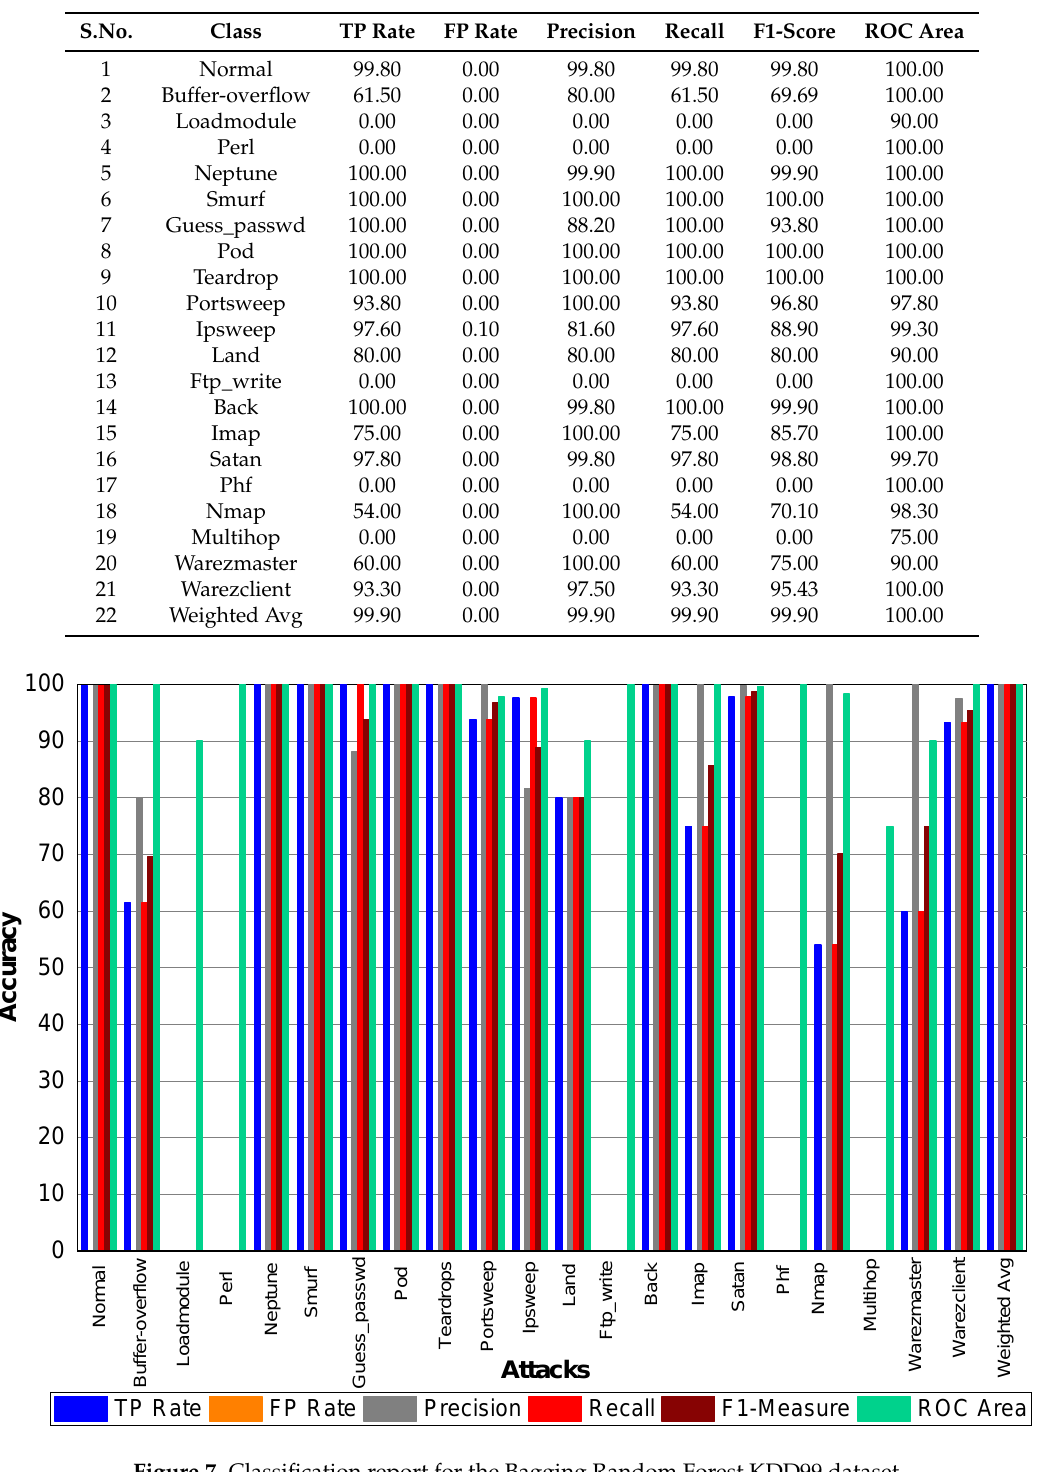
Figure 7. Classification report for the Bagging Random Forest KDD99